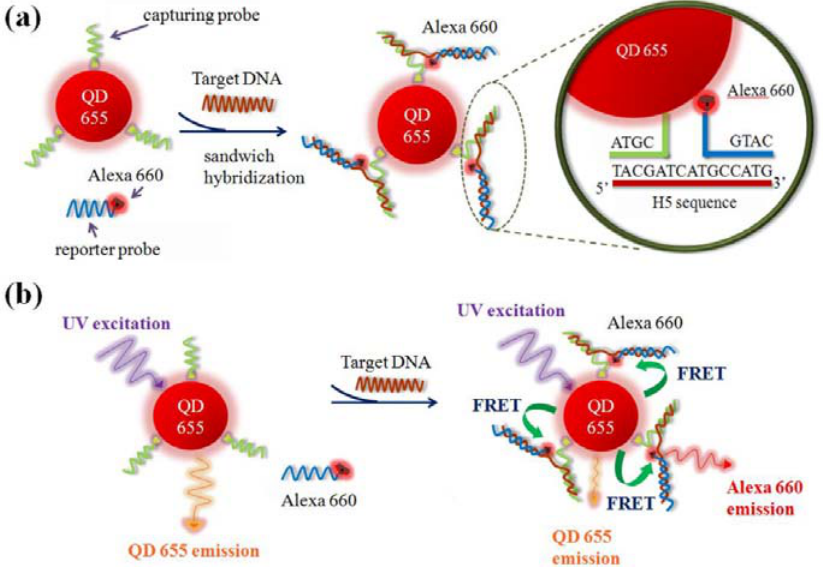
Figure 4. Schematic illustration of the sandwich hybridization assay with a QD-induced FRET reporter system for H5 target DNA detection: ( a ) sandwich hybridization with label-free H5 sequence (target) by the capturing probes conjugated on QD655 (FRET donor) and the reporter probes labeled with Alexa Fluor 660 (FRET acceptor); ( b ) FRET emission shift before and after the sandwich